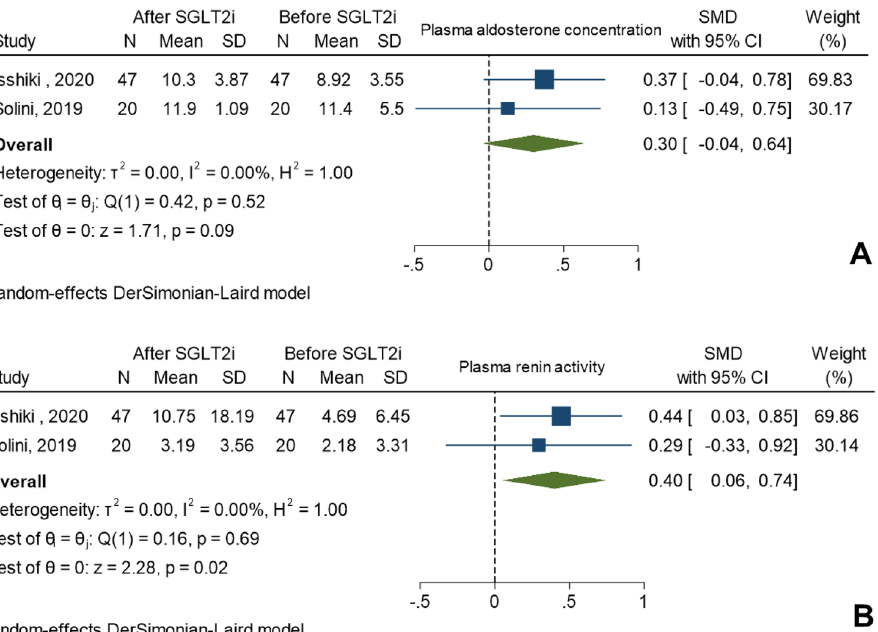
Figure 2. Forest plots of changes in ( A ) plasma aldosterone concentration and ( B ) plasma renin activity after the use of SGLT2i in randomized controlled